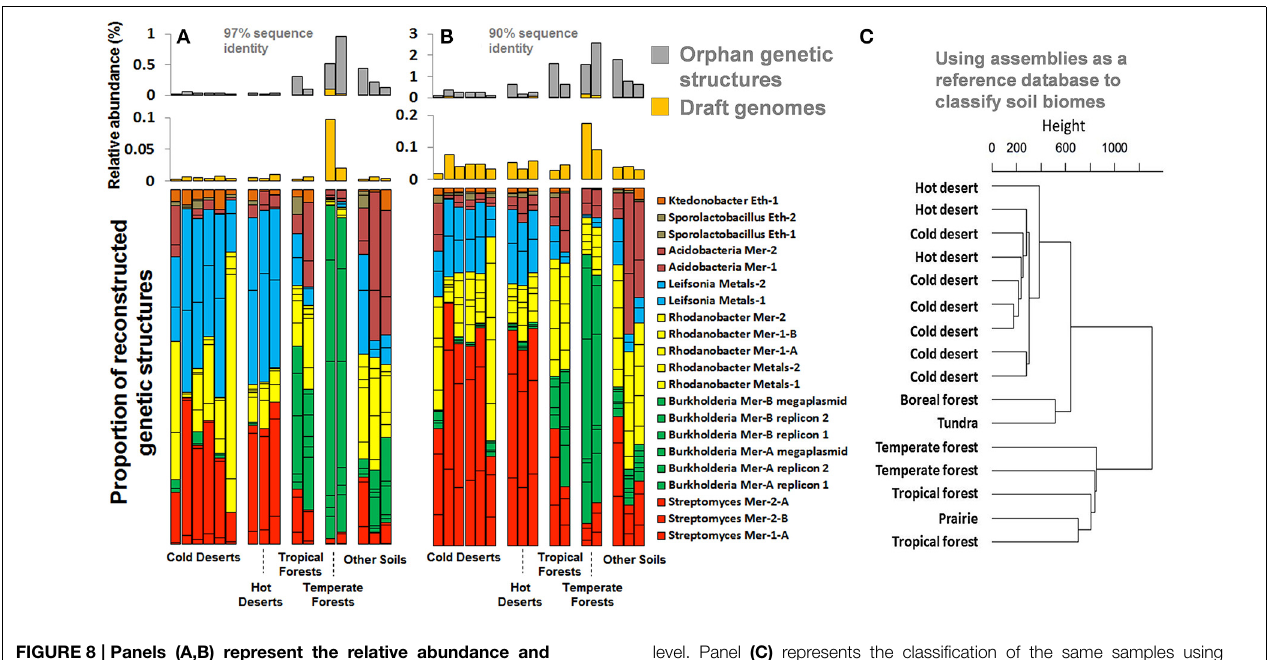
level. Panel (C) represents the classification of the same samples using our assemblies (genomes and orphan genetic structures) as a reference database and a 90% sequence identity cut-off for mapping. The dendrogram was generated using Ward’s method with Euclidean